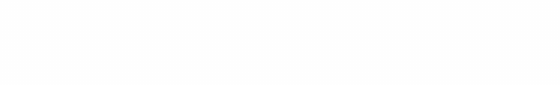
___ FIG. 4. Addition of different concentrations of C.d.terrificus venom to cultures of peritoneal macrophages. Effect on the spreading activity of resident (SP-re, +) and inflammatory (Sp-in, A) cells, and on phagocytosis of inflammatory (Pha-in, O) cells. S.E.M. of cultures from five mice. *p Each point is the mean < 0.05.